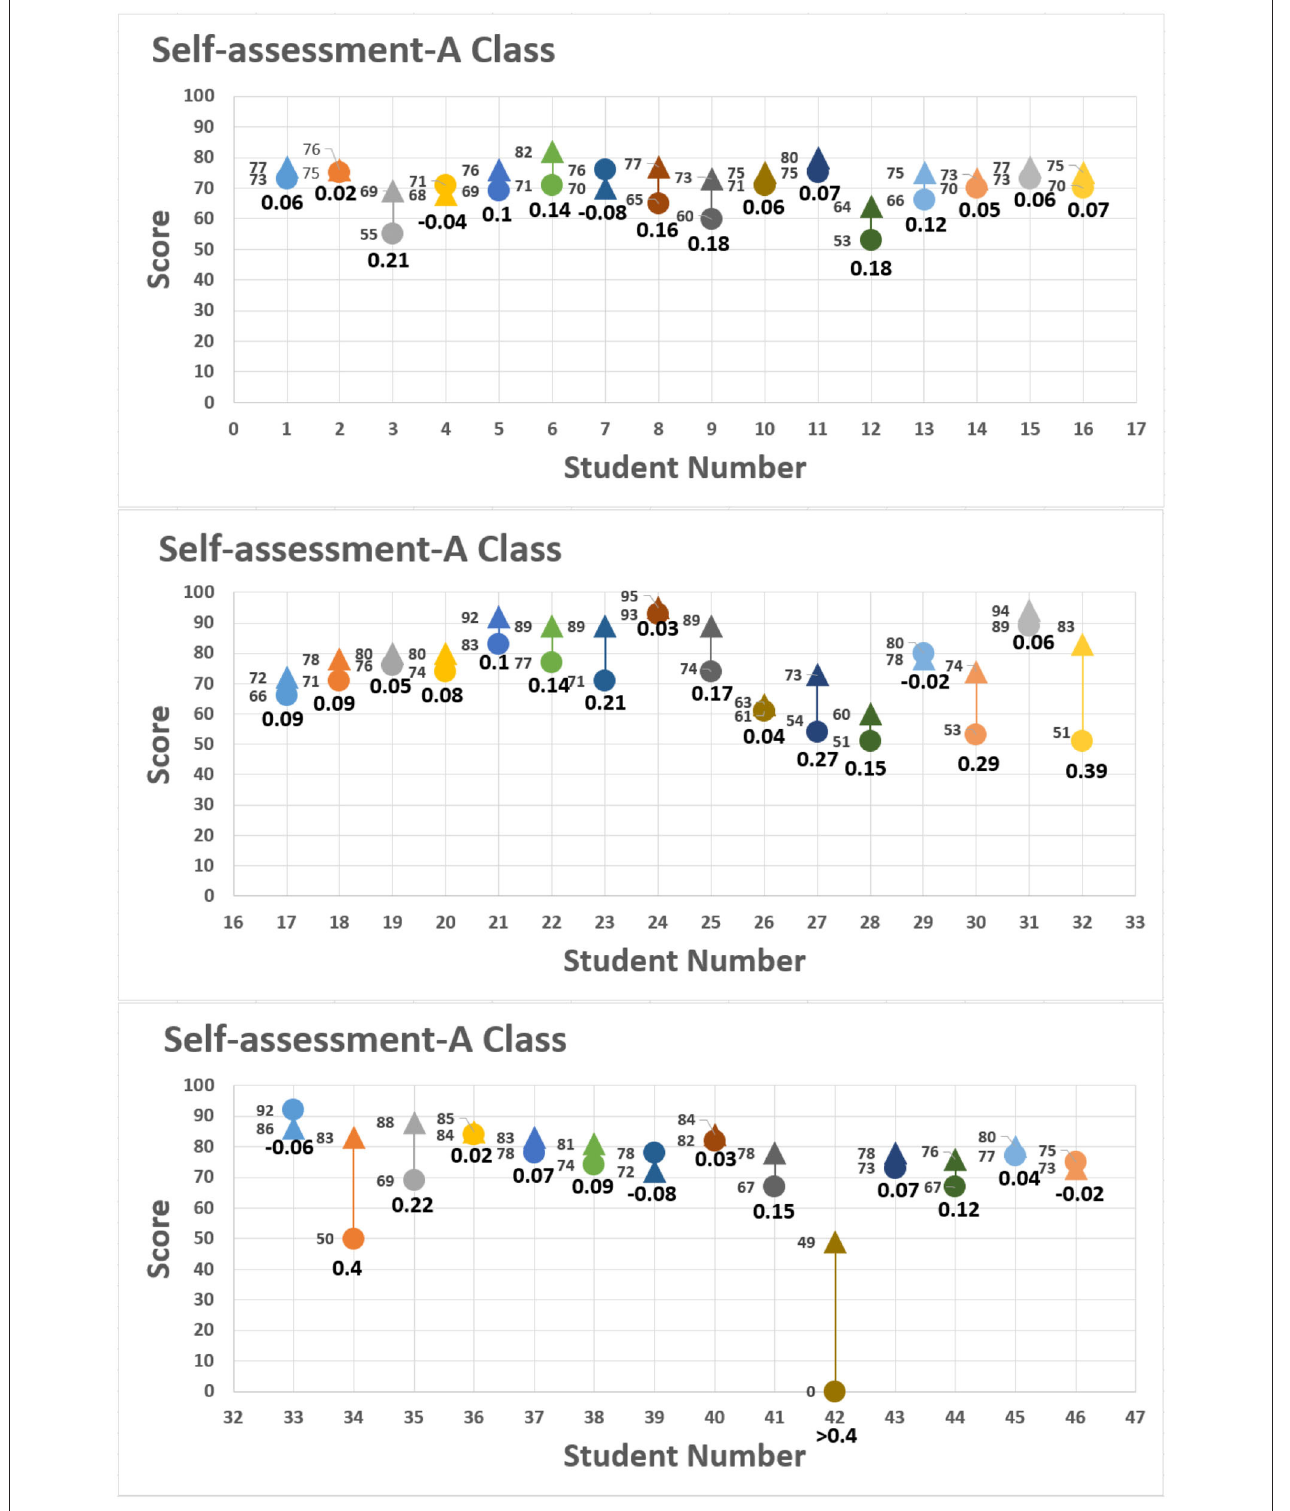
FIGURE 7 | Self-assessment: class